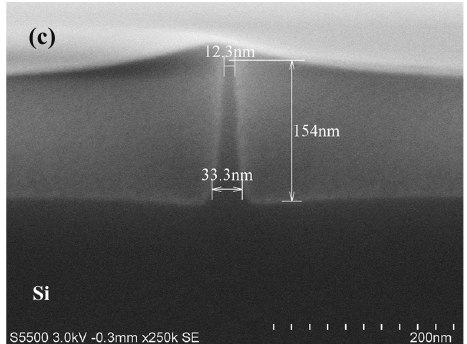
Figure 3. Si-fins with different aspect ratios: ( a ) height ≈ 115 nm, width ≈ 38 nm; AR ≈ 3:1; ( b ) height ≈ 175 nm, width ≈ 23 nm, AR ≈ 8:1. ( c ) The structure in ( b ) after the removal of HM, STI filling and dry etching (height ≈ 154 nm, width ≈ 20 nm, AR ≈ 8:1).